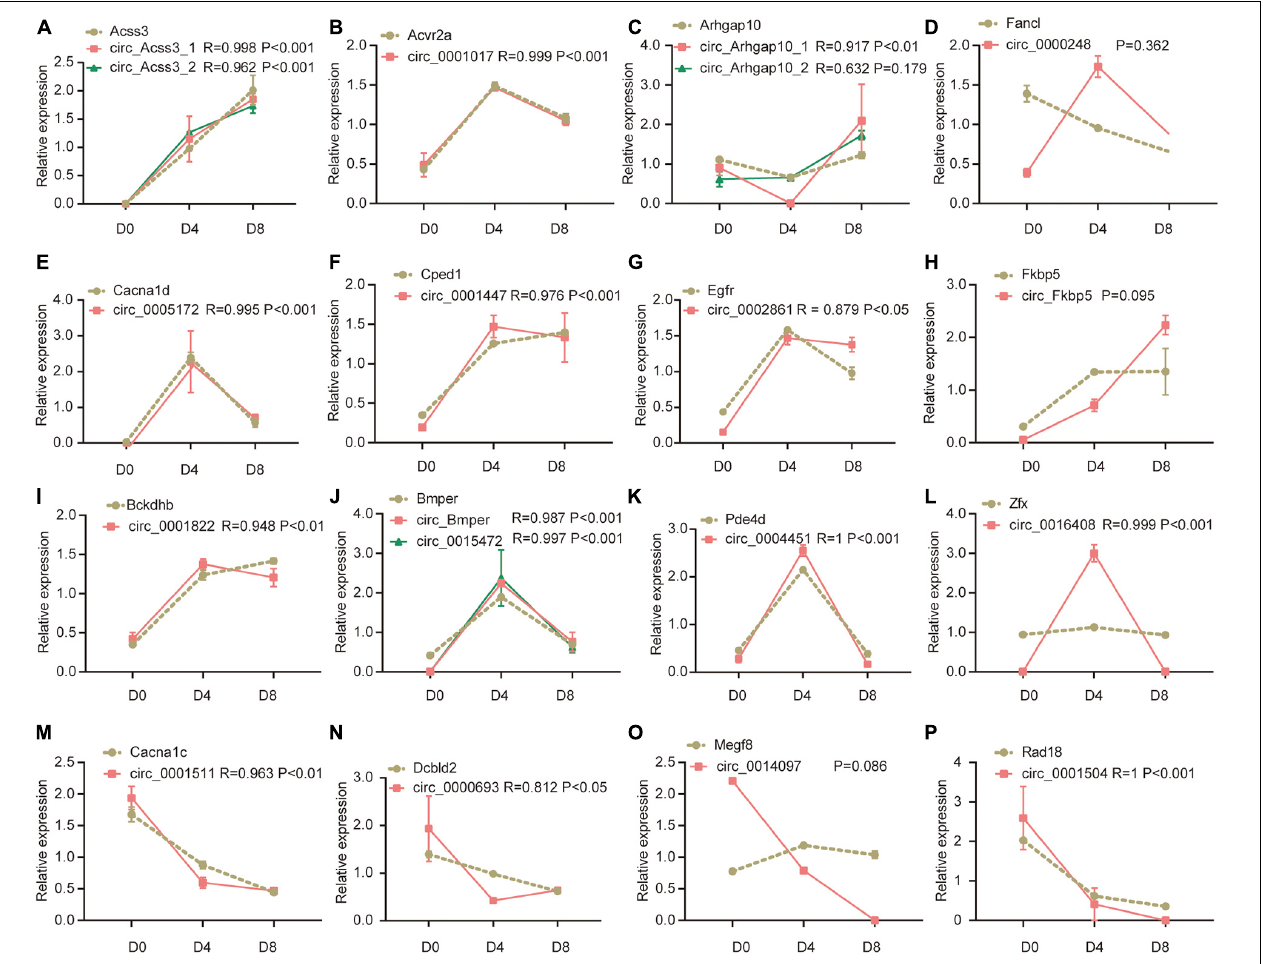
FIGURE 4 | Representative results of correlation analysis between differentially expression circRNAs and their parental genes during adipogenesis. For the convenience of drawing both circRNA and mRNA expression in the figure, the relative expression level was used (expression level at each time point was divided by its average expression level across adipogenesis). (A–P) The correlation between Acss3, Acvr2a, Arhgap10, Fancl, Cacna1d, Cped1, Egfr, Fkbp5, Bckdhb, Bmper, Pde4d, Zfx, Cacna1c, Dcbld2, Megf8, Rad18, and their corresponding